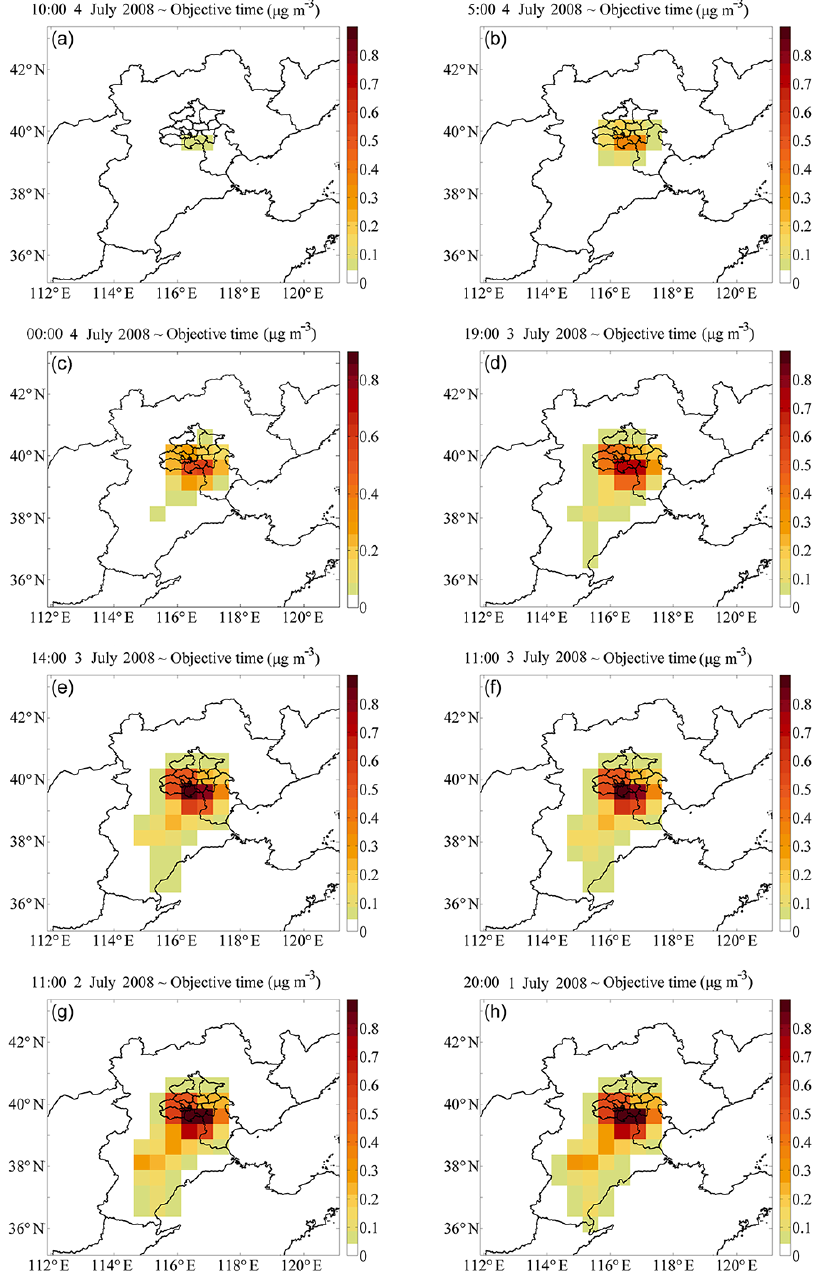
Figure 6. Cumulative sensitivity coefficient distribution. Panels (a – e) are 1, 6, 11, 16, and 21h cumulative sensitivity coefficients. Panels (f – g) are 24 and 48h cumulative coefficients, and (h) is the last backward simulation time step.